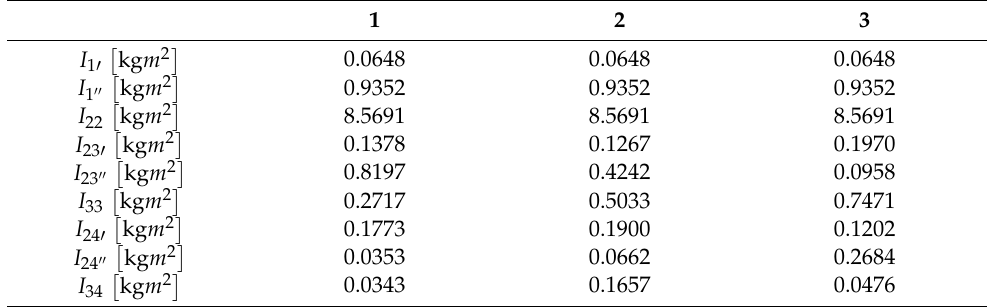
Table 3. Parameters of inertial